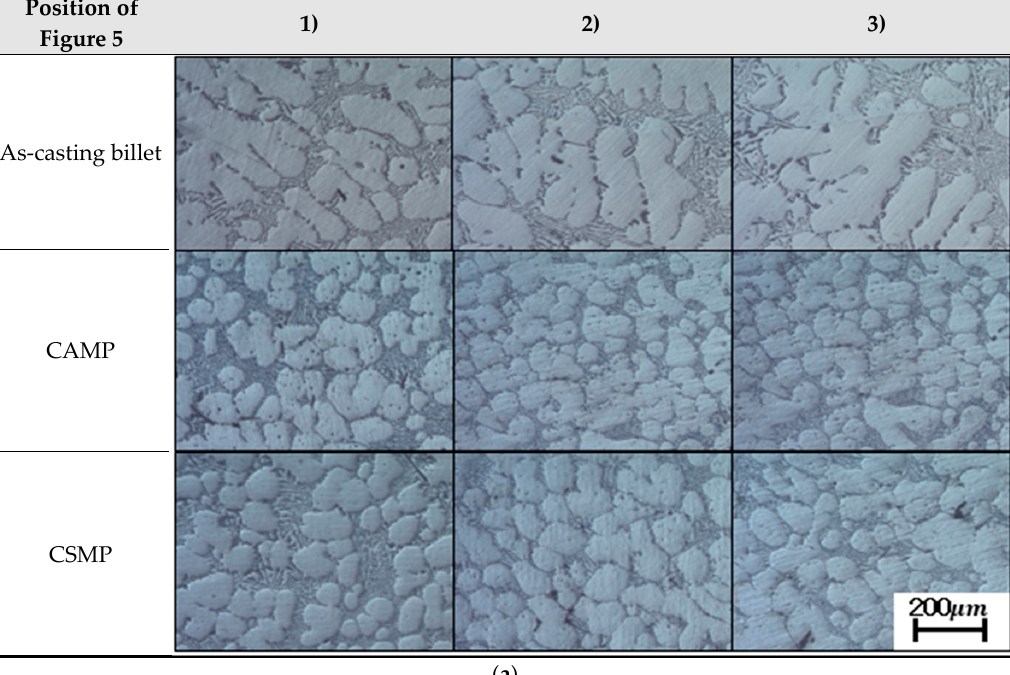
( b ) Figure 7. Microstructure of A356 100×: ( a ) measurement point of center; ( b ) measurement point of surface. Figure 8 shows the mean diameters and roundness of the solid particles at the center and the surface of the slurries with current input to the symmetrical poles counterclockwise, where the largest magnetic flux density occurred and with current input to the adjacent poles counterclockwise, as well